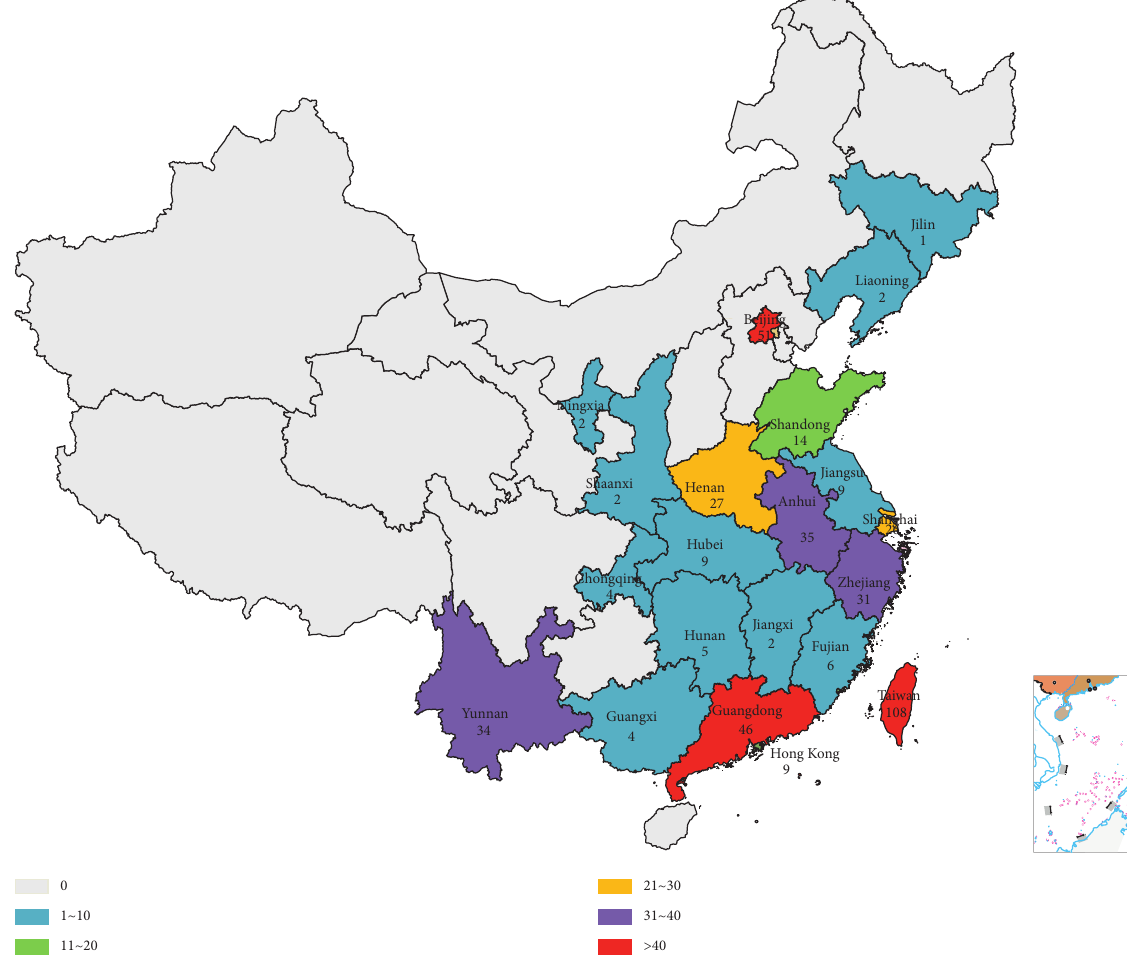
Figure 2: The number of EV-A71 isolated strains with the complete genome in different provinces of China. The EV-A71 isolated strains with a complete genome cover a total of 22 provinces. Orange represents less than 5 isolates, yellow represents between 5 and 12 isolates, lavender represents between 12 and 30 isolates, and dark purple represents greater than 30